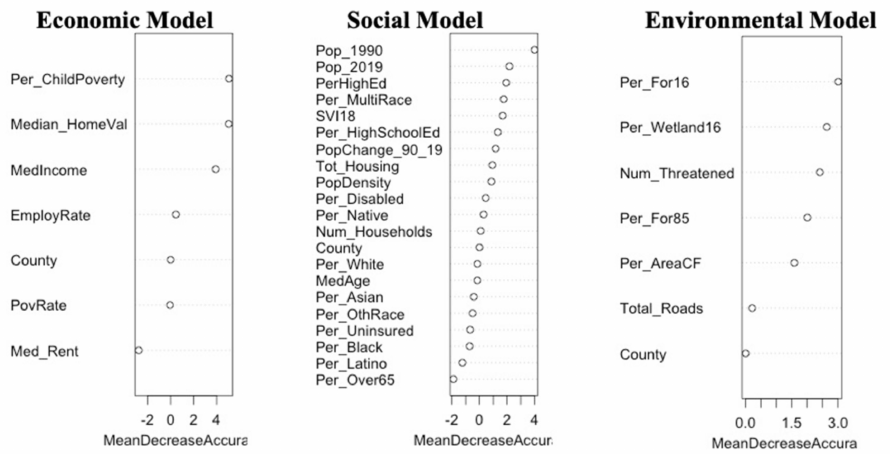
Figure 6. Variable importance for models run by data type (social, economic, and